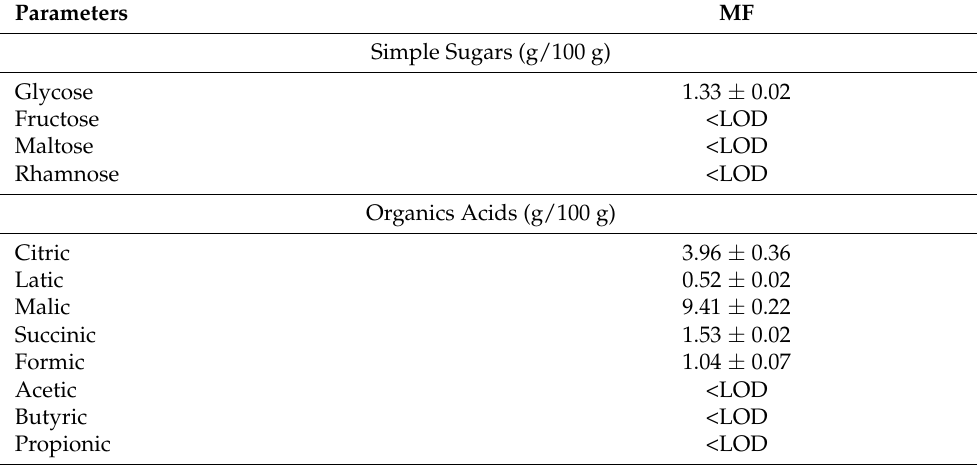
Table 3. Sugar and organic acid profile (media ± standard deviation) of MF.